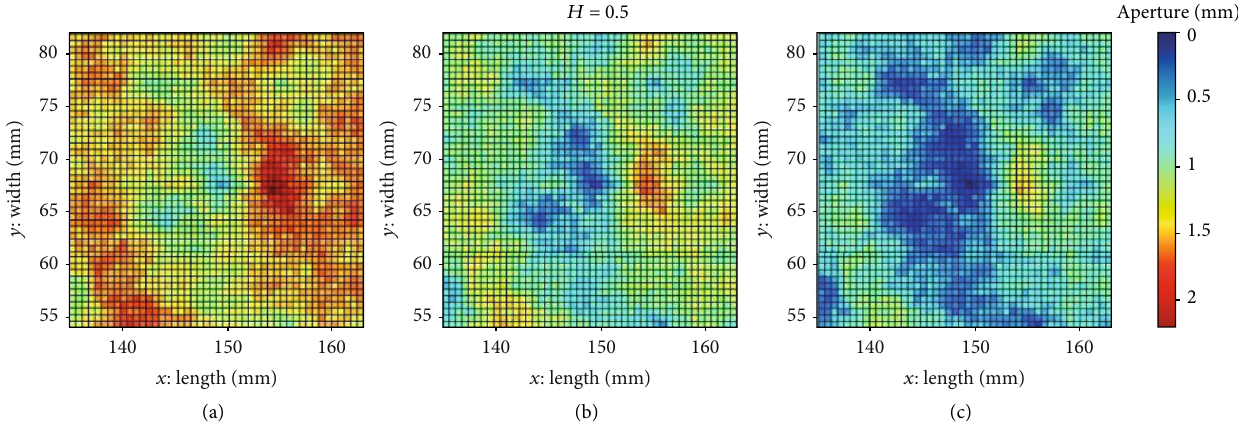
Figure 2: Aperture distribution with H = 0 : 5 : (a) σ